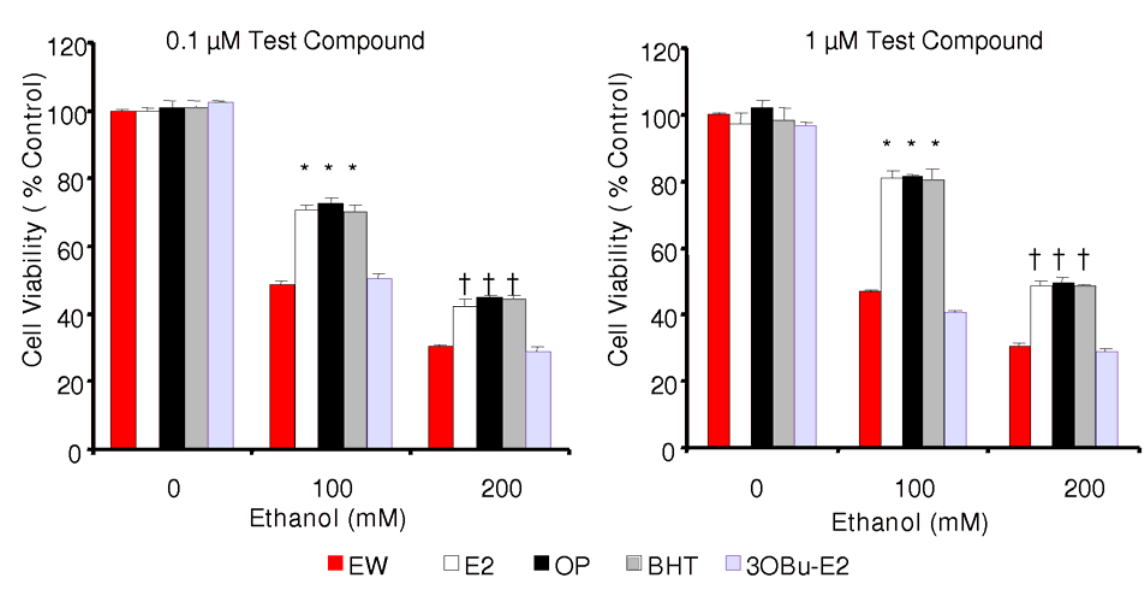
Figure 3. Effect of E2, OP, BHT and 3OBu-E2 on EW-induced cytotoxicity. Data are given as mean ± S.E.M. (n=4),*p<0.001 and †p<0.01 vs. corresponding EW control (no test compound)